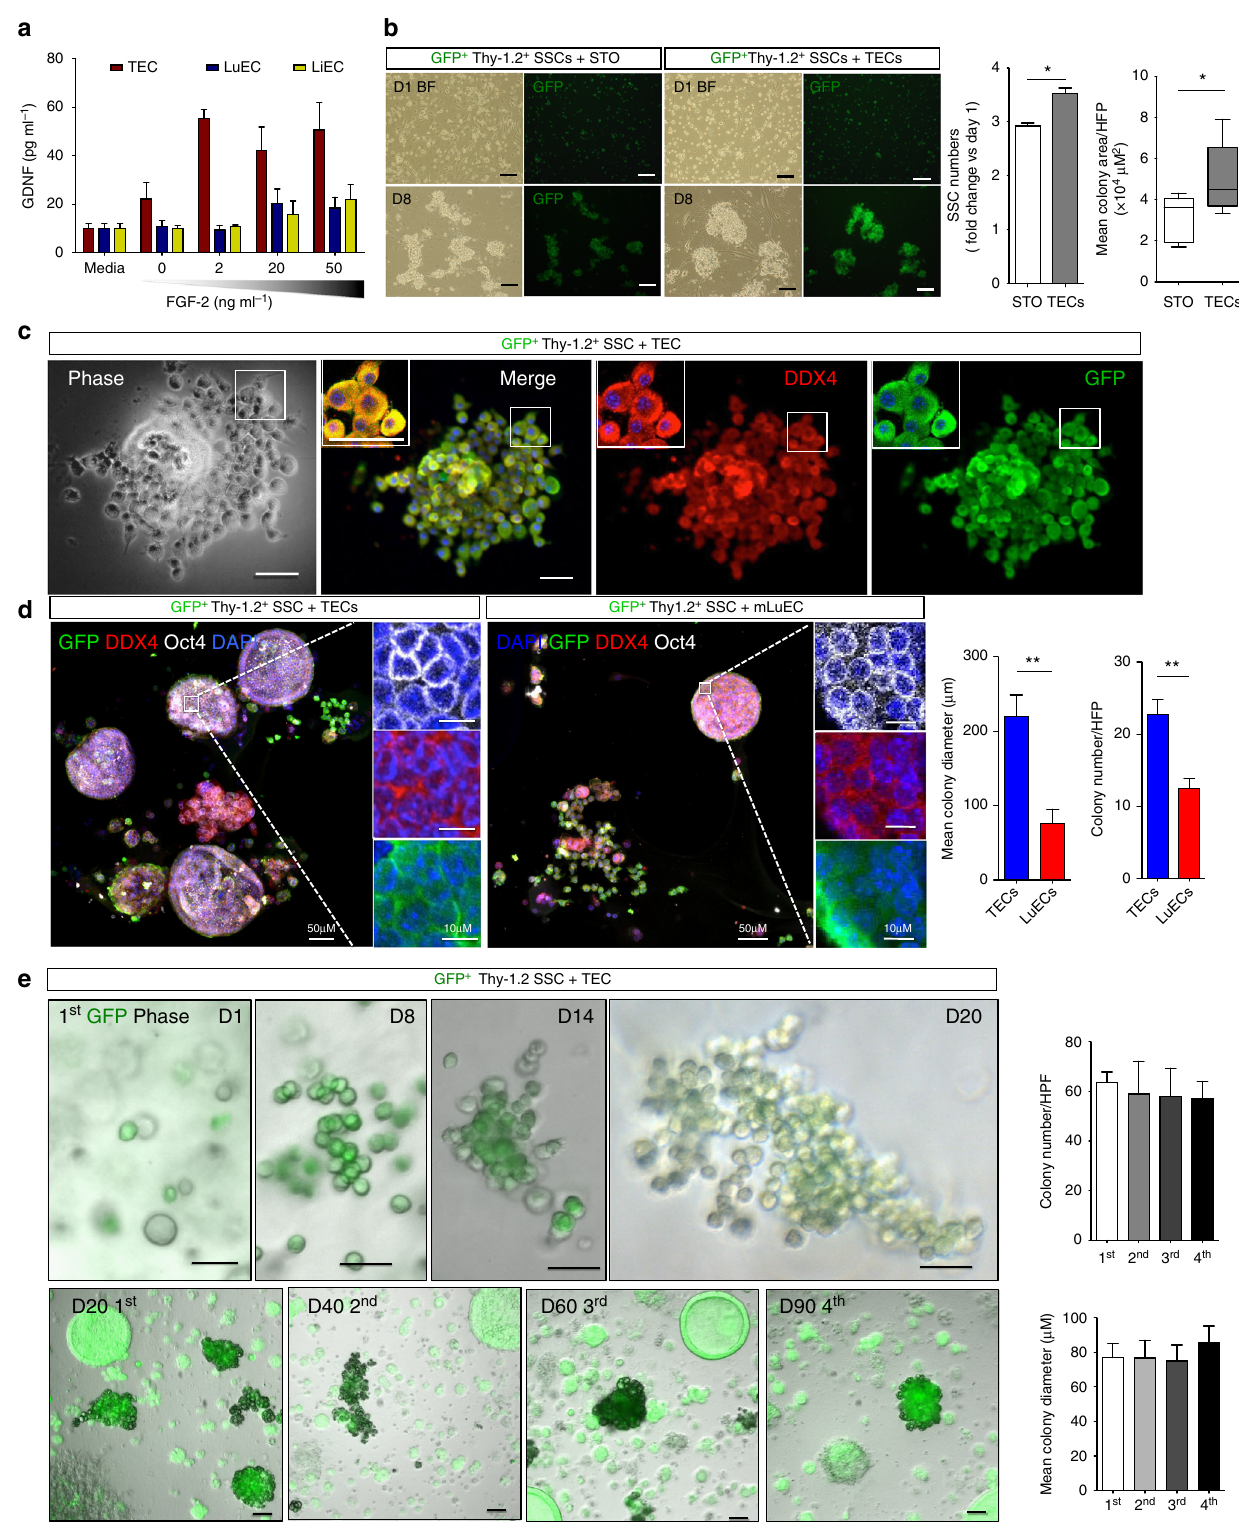
early as 2 weeks after plating. Colonies were immunostained for the expression of the germ stem cell markers DDX4 and Oct4 (Fig. 2d and Supplementary Figure 6d). Of note, spheroid colonies generated by co-cultures of GFP + Thy-1.2 + SSC- enriched cells with LuECs were signi fi cantly smaller in diameter